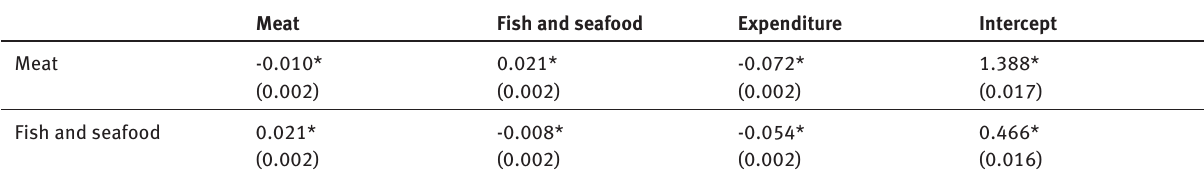
Table 3: Coefficient estimates for aggregate model1 Meat Fish and seafood Expenditure